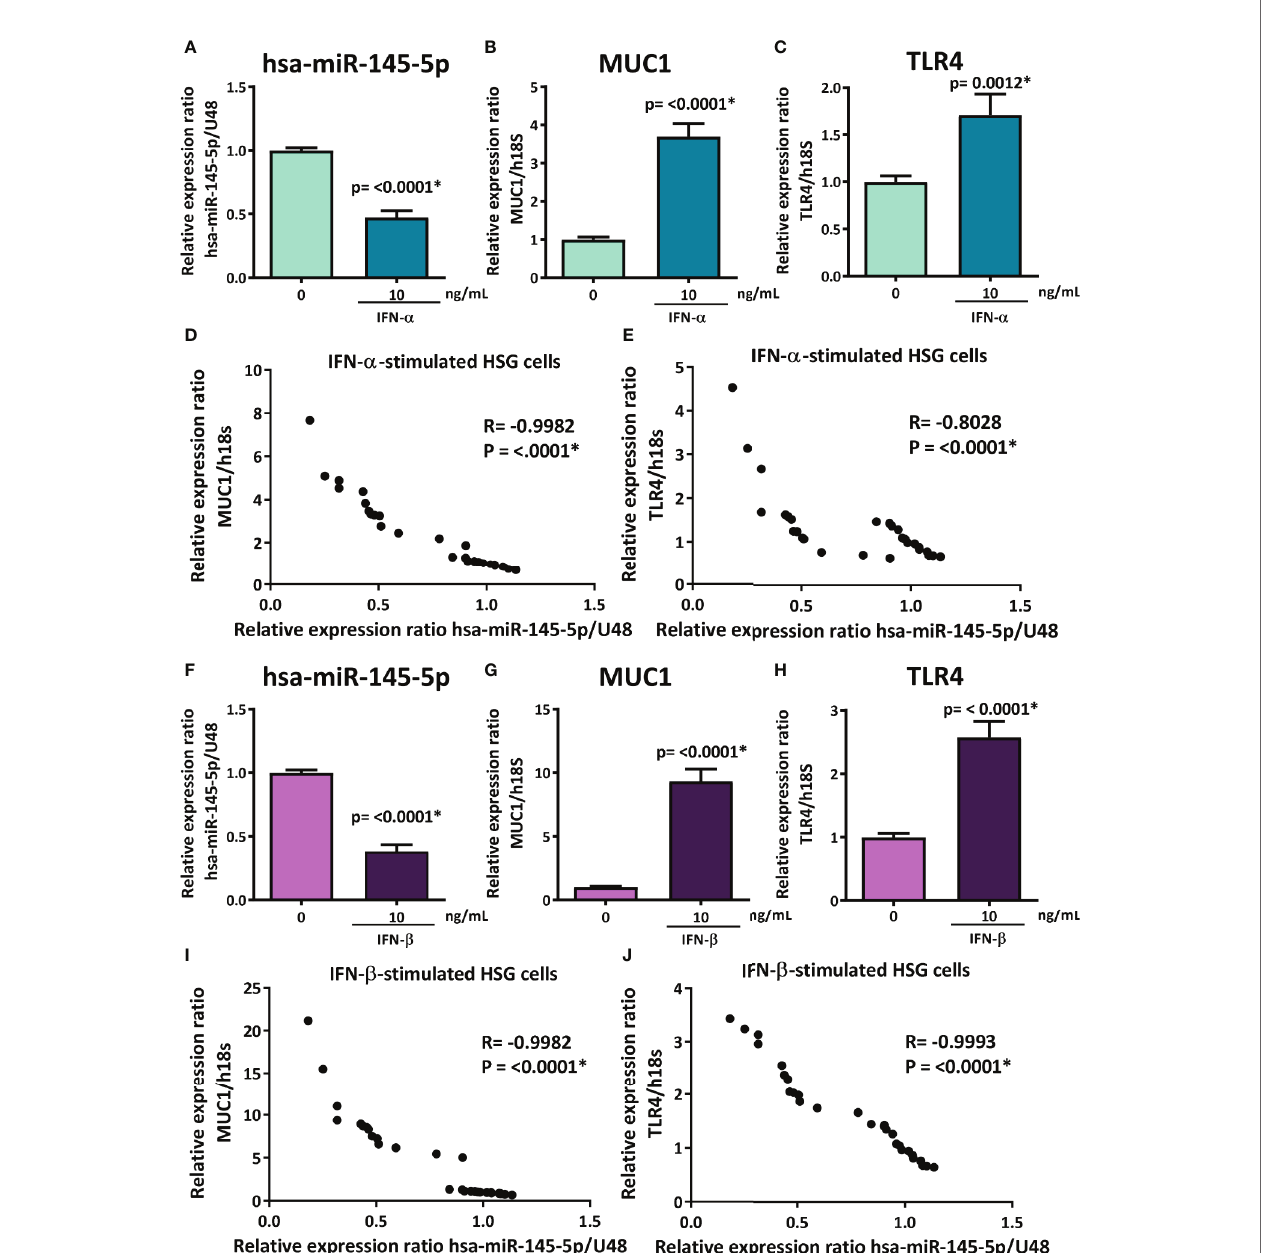
FIGURE 5 | hsa-miR-145-5p is downregulated and MUC1 and TLR4 are overexpressed in type I IFNs-stimulated HSG cells. (A) hsa-miR-145-5p levels in HSG cells stimulated with or without 10 ng/mL human recombinant IFN- a for 24 h. U48 was used as a housekeeping gene. Transcript levels of MUC1 (B) and TLR4 (C) in HSG cells stimulated with IFN- a . Spearman correlation between hsa-miR-145-5p and MUC1 (D) or TLR4 (E) transcript levels in IFN- a stimulated HSG cells. (F) hsa- miR-145-5p levels in HSG cells stimulated with or without 10 ng/mL human recombinant IFN- b for 24 h. U48 was used as a housekeeping gene. Transcript levels of MUC1 (G) and TLR4 (H) in HSG cells stimulated with IFN- b . Spearman correlation between hsa-miR-145-5p and MUC1 (I) or TLR4 (J) transcript levels in IFN- b stimulated HSG cells. Data are representative of at least three independent experiments. (*) p-value ≤ 0.05 was considered signi fi